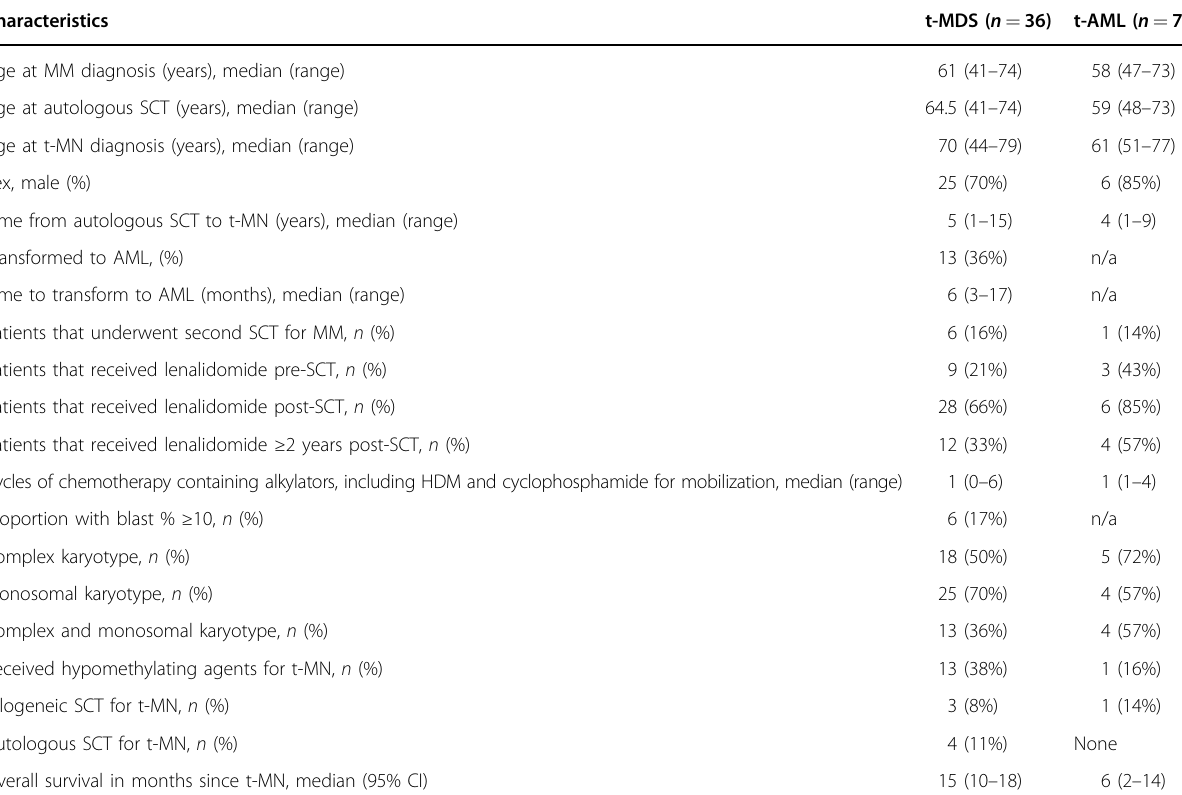
Table 1 Clinical and pathologic characteristics of multiple myeloma (MM) patients that developed therapy-related myeloid neoplasm